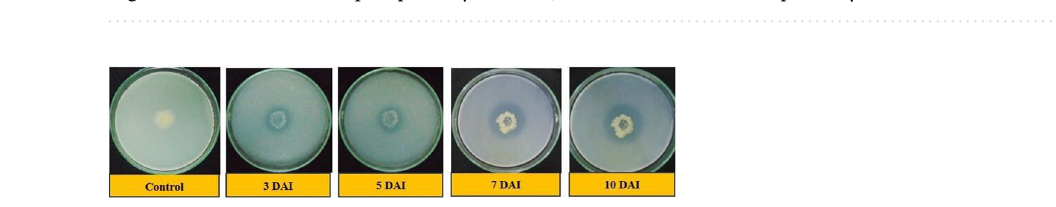
Figure 3. Solubilization of phosphate by isolate S 8 on 3, 5, 7 and 10 DAI respectively.